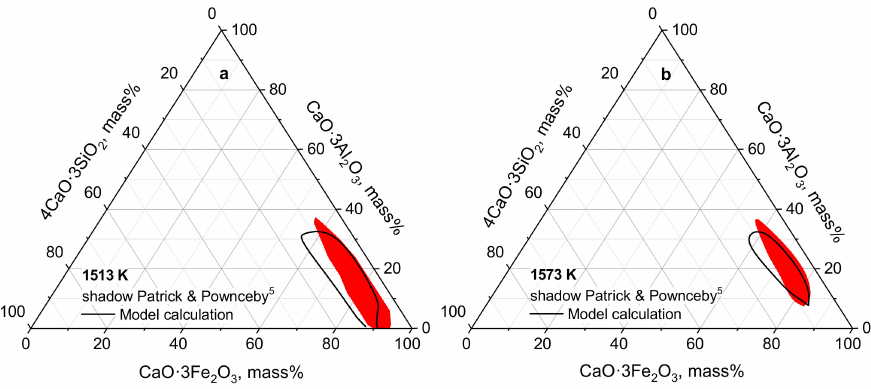
Figure 3. The comparison of the calculated and experimental measured SFCA stability [5] within the CCC plane at ( a ) 1513 K and ( b ) 1573 K.